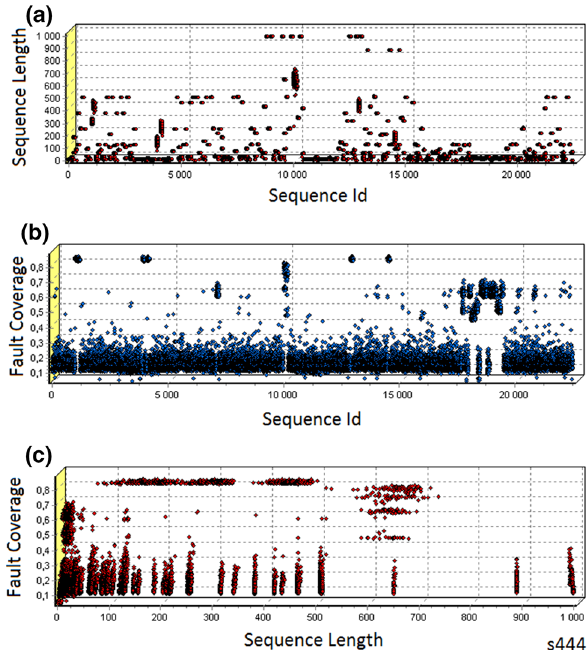
Fig. 13 Simulation graph for s444 a sequence length vs. sequence id, b FC vs. sequence id and c FC vs. sequence length. STP (Id 1–7500), CSTP (Id 7501–15000), CSTP with additional DFF (Id 15001–22500)